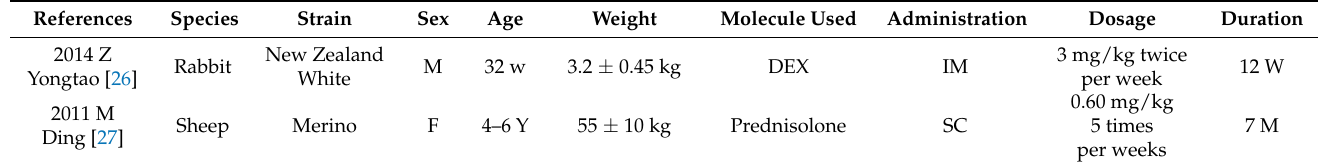
Table 2. Main characteristics of the proposed experimental protocol to induce GIOP in rabbit and